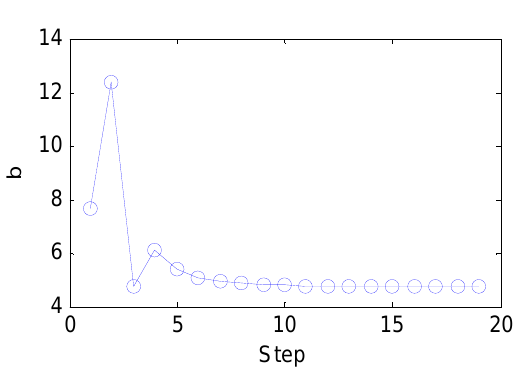
Figure 13. The curve of b versus step.